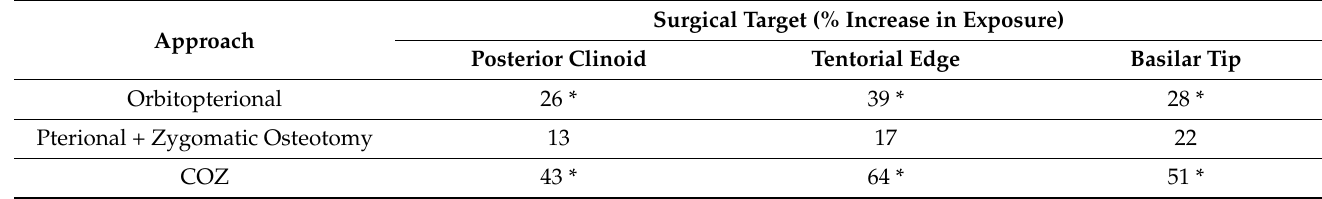
Table 2. Percentage increase in exposure of different targets according to Schwartz et al.